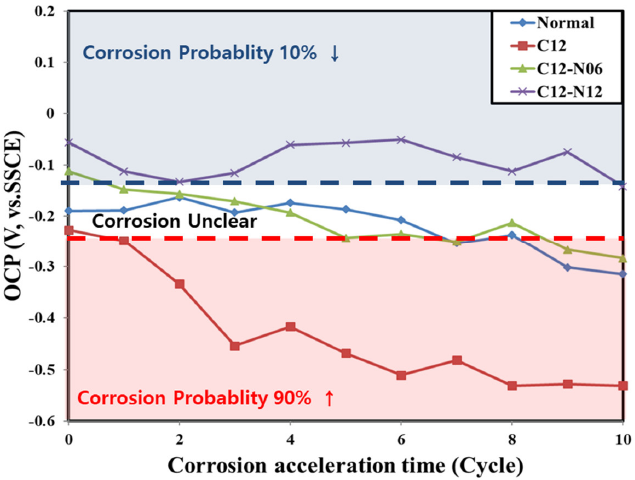
Figure 6. OCP of the rebars embedded in concrete according to the corrosion acceleration cycle. For the normal concrete, the OCP did not change significantly as compared to the other samples and remained stable between −0.25 and −0.15 V until the end of 10 weeks of accelerated corrosion, whereby it decreased to −0.315 V. For the C12N6 concrete, the OCP decreased with time from −0.1 to −0.284 V, at a rate much lower than that in the case of the concrete containing only chloride ions. This can be attributed to LiNO 2 , which acts to retard the degradation of the stable passive film that forms around the embedded rebar owing to the strong alkaline nature of the concrete mixture [22,35,36]. For the normal and C12N6 concrete samples, the corrosion status was uncertain until after 9 weeks of cycles, where it entered the initial phase of corrosion, as per ASTM C 876 [34]. For the C12N12 concrete with 1.2 kg/m 3 chloride ions and 1.2 M LiNO 2 , the OCP re- mained stable between −0.05 and −0.15 V. The OCP after 10 weeks of cycles was measured to be −0.142 V, corresponding to less than 10% corrosion as per ASTM C 876, implying that no significant corrosion had taken place. This is because the use of an LiNO 2 concen- tration equal to or higher than 1.2 M inhibits the degradation of the passive film surround- ing the embedded rebar. 3.2. Electrochemical Results The Bode modulus plot shows the impedance Z as a function of the applied fre- quency. The plots can be categorized by the impedance at a high frequency and the im- pedance at a low frequency. At a high frequency, the impedance can be used to determine the electrolyte resistance based on the electrode reaction time, and at a low frequency, the polarization resistance of the rebars due to the diffusion and movement of the substances can be identified [27–29]. The Bode modulus plots of all test specimens at the selected accelerated corrosion cycles are shown in Figure 7.